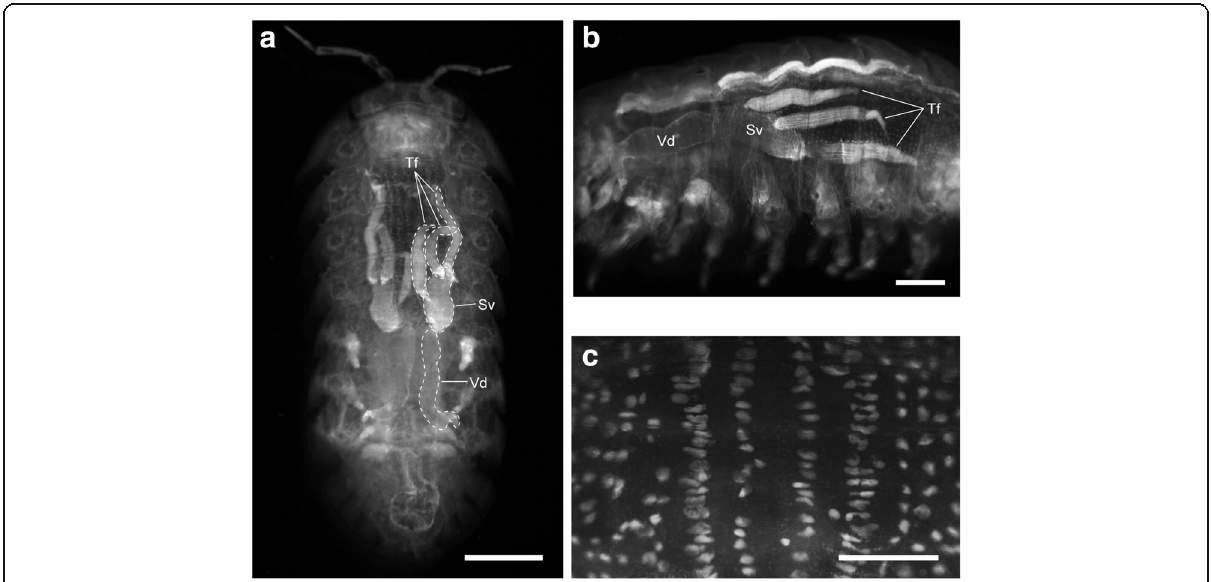
Fig. 3 Propidium iodide (PI) staining of a cleared A. vulgare male. a Top view of the stained specimen. Dotted lines indicate the contour of male reproductive organs. Legs are removed. Scale bar = 2 mm. b Side view of the middle body part. Scale bar = 1 mm. Testis follicles (Tf), sperm vesicle (Sv), vas deferens (Vd). c Close-up image of the dorsal anterior hindgut. Large cell nuclei aligned in ordered rows. Scale bar = 500 μ